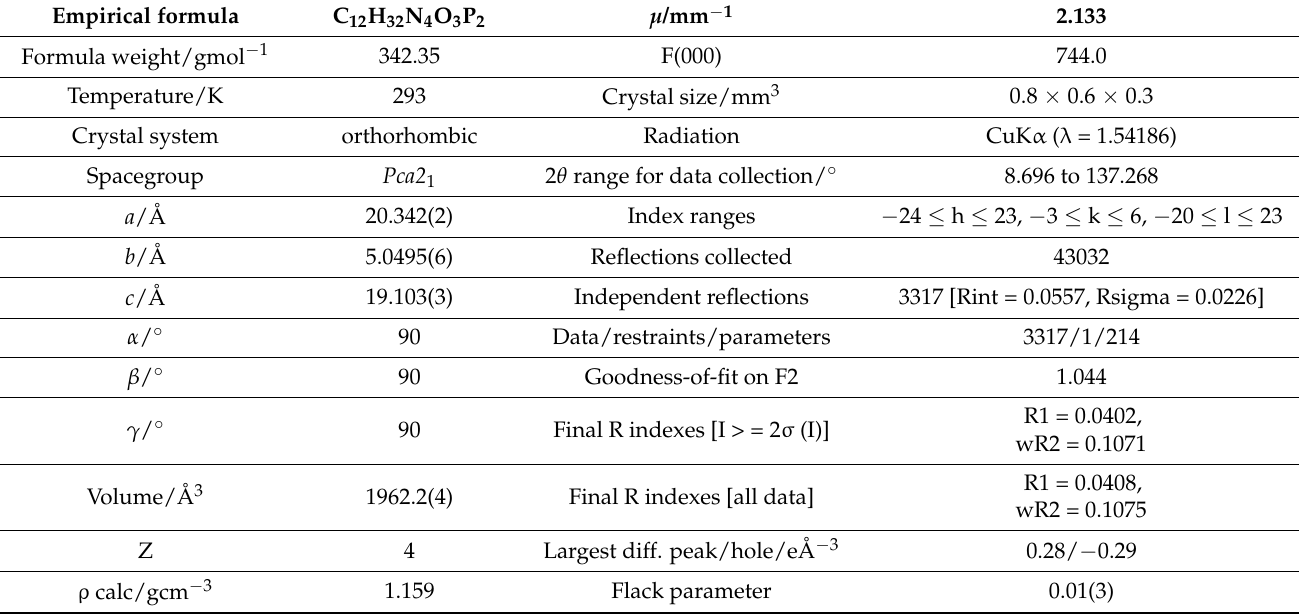
Table 1. Crystal data and structure refinement for O( i PrNH) 2 PO) 2